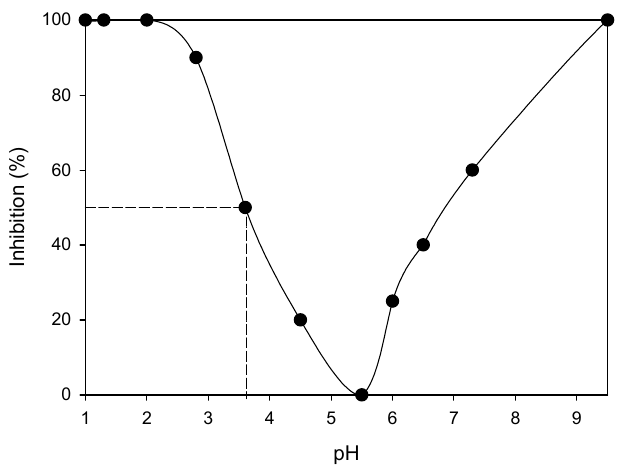
Figure 4. Effect of pH on seedling development.